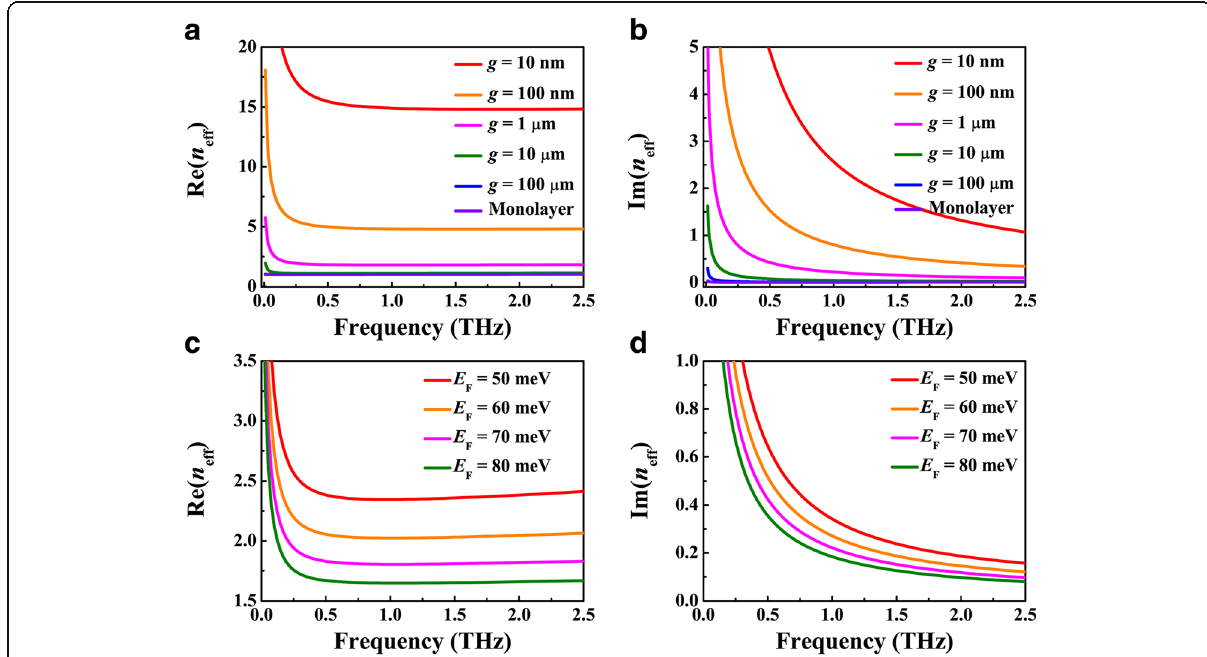
Fig. 2 Real and imaginary parts of the effective refractive index n eff for a , b different gap width g , where the Fermi energy of BDS is fixed to be E F = 70 meV, and c , d different values of the Fermi energy E F , where the gap width is fixed at g = 1 μ